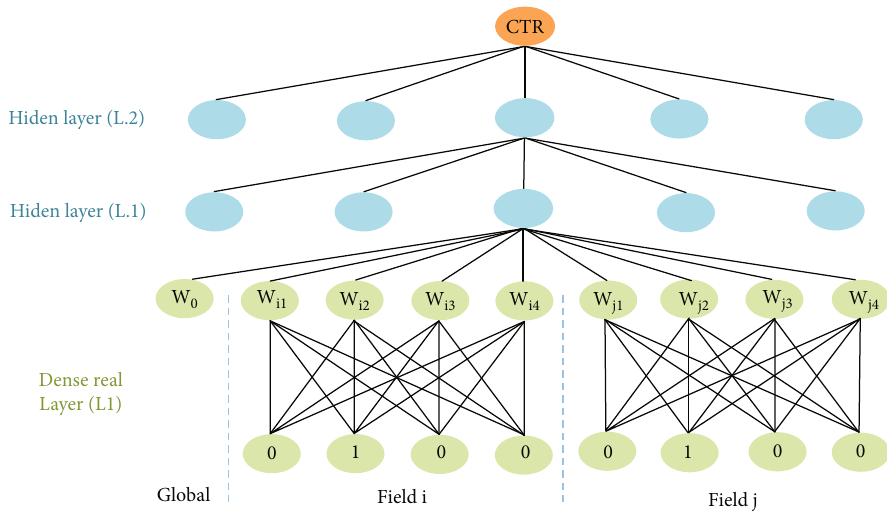
Figure 2: Four-layer FNN algorithm model structure